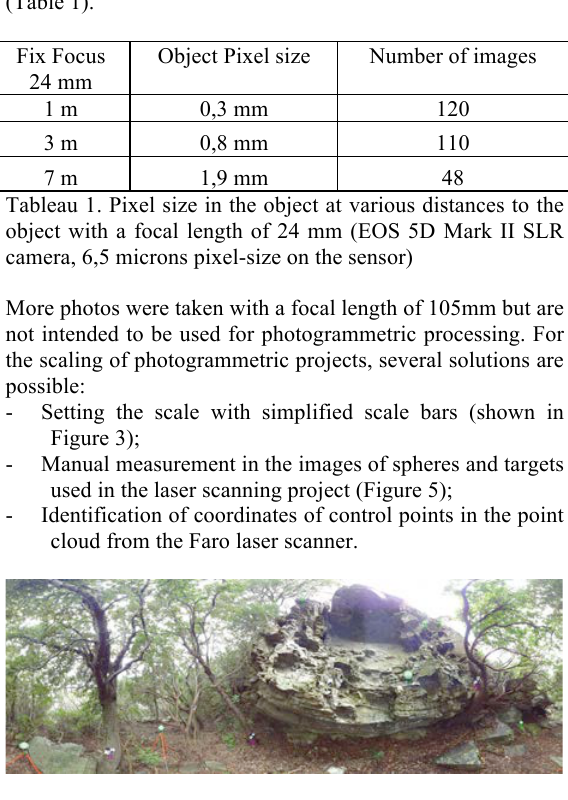
Figure 5. Distribution of the spheres and targets in a panoramic image generated by the Webshare of Faro Scene 4. DELIVERABLES